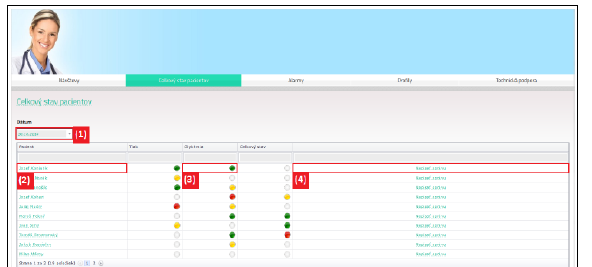
Figure 3. HPU web interface with status preview of recorded health parameters (red color indicating alarming thresholds; yellow - borderline values; green - good health conditions; white - no measurements)